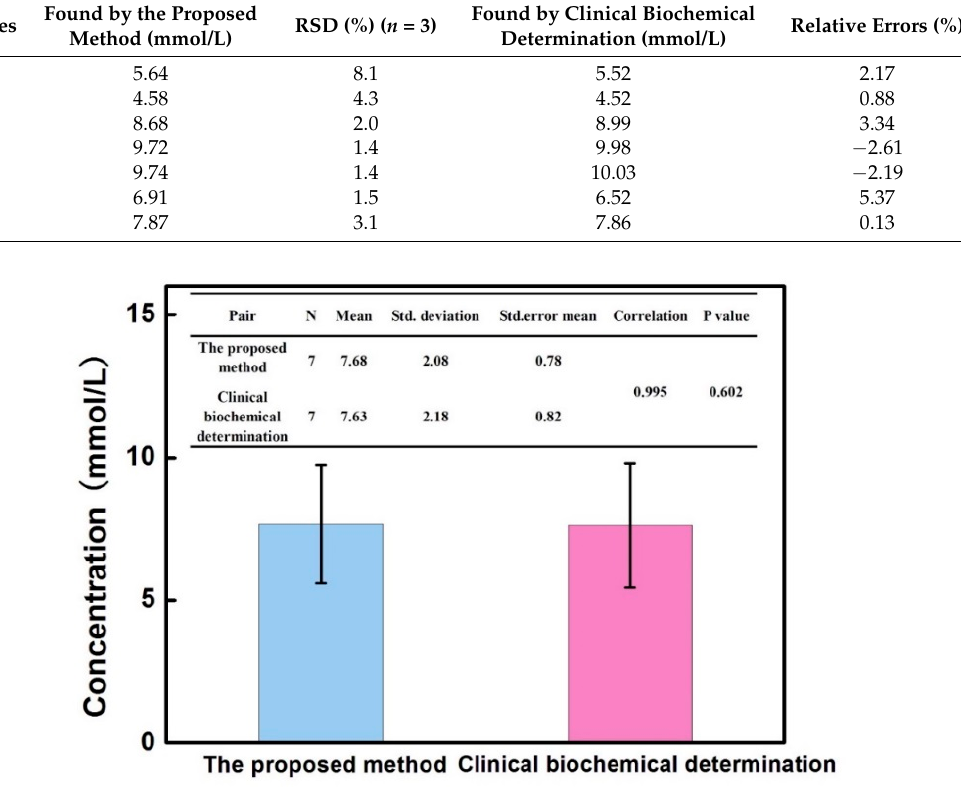
Figure 6. Statistics, correlation and the paired t -test of the proposed method and clinical biochemical determination. Error bars showed the varied concentration of glucose in different clinical samples.